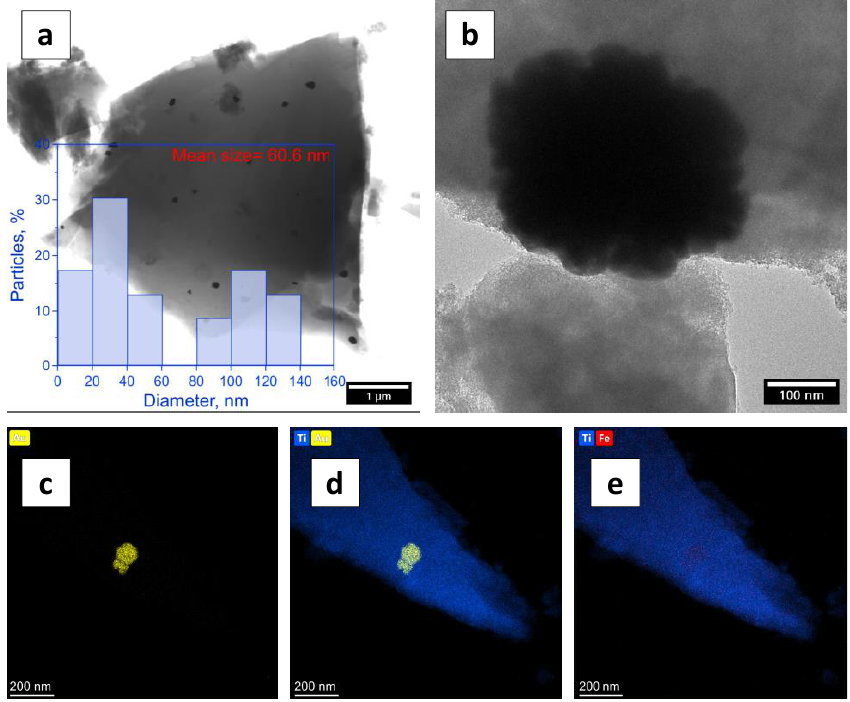
Figure 6. TEM images of the obtained FeN-Au/TiO 2 sample: SE mode with particle size distribution ( a ), SE mode ( b ), EDS HAADF analysis of Au ( c ), EDS HAADF analysis of Ti and Au ( d ), and EDS HAADF analysis of Ti and Fe ( e ).